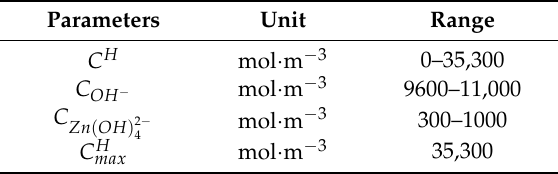
Table 2. Range [28].